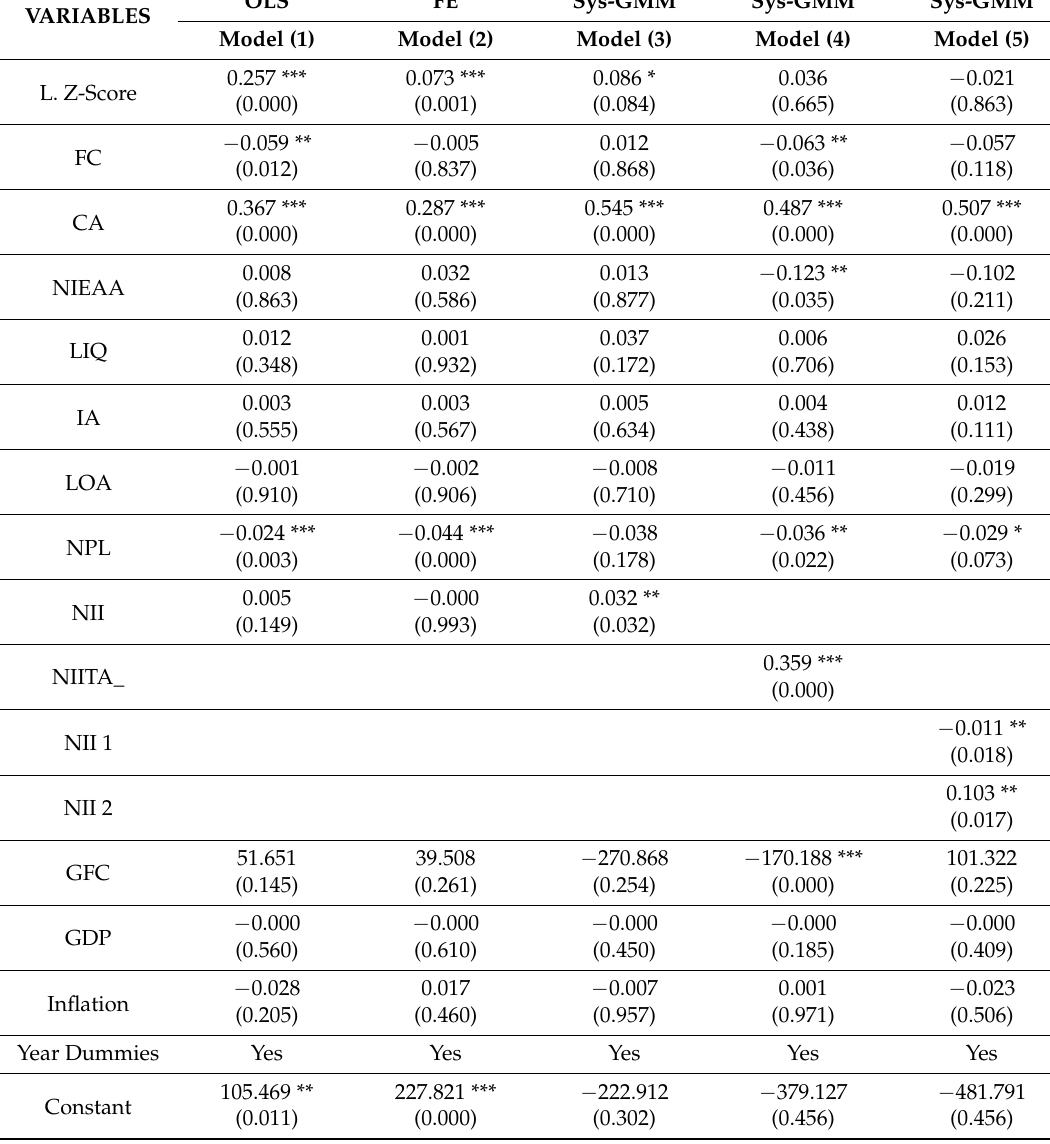
Table 8. Results for alternative measure of bank stability (Z-Score) as dependent